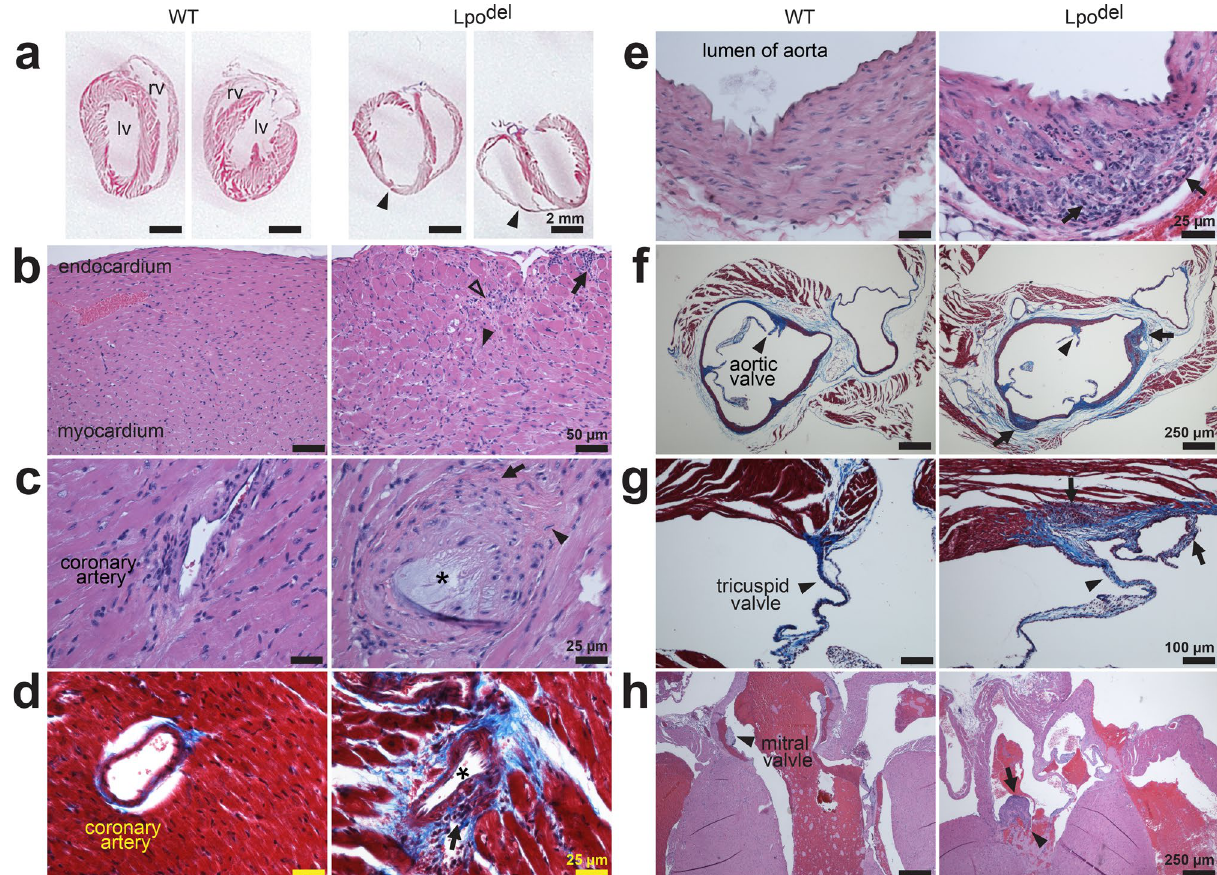
Figure 2. Cardiac histopathology of Lpo del mice. ( a ) Digitized scans of MT-stained sections of hearts from two wild-type (left) and two mutant (right) mice. In the mutant sample, left and right ventricles (lv and rv) were dilated, with thinner ventricular walls (arrowheads). ( b – h ) Histomicrographs of cardiac tissue sections of wild-type (left) or mutant (right) mice, stained by HE unless specified otherwise. ( b ) Sections of part of the left ventricle. The mutant sample exhibited inflammatory infiltrates (arrow) underneath the endocardium and myocytes degeneration (closed arrowhead) with apparent fibrosis (open arrowhead). ( c ) Sections of the coronary artery. In the mutant sample, infiltrating leukocytes (arrow) and apparent fibrosis (arrowhead) were present around a coronary artery, which contained an apparent greyish plaque (asterisk). ( d ) MT-stained sections where the mutant sample exhibited infiltrating leukocytes (arrow) and heavy collagen deposition (blue) around the narrowed coronary artery (asterisk). ( e , f ) Sections of the aorta exhibiting clusters of infiltrating leukocytes (arrows) in the mutant samples. MT-stained cross-sections revealed increased collagen deposition (blue, f ) in and around the aortic wall of the mutant sample. ( g ) MT-stained sections displaying the tricuspid valves pointed at by the arrowheads. The mutant sample exhibited infiltrating leukocytes (arrow) and increased collagen deposition (blue). ( h ) Sections displaying the mitral valves pointed at by the arrowheads. The mutant sample exhibited infiltrating leukocytes (arrow) with apparent fibrosis in the mitral valve. Scale bars are 25 µm ( c – e ); 50 µm ( b ); 100 µm ( g ); 250 µm ( f , h ); 2 mm ( a